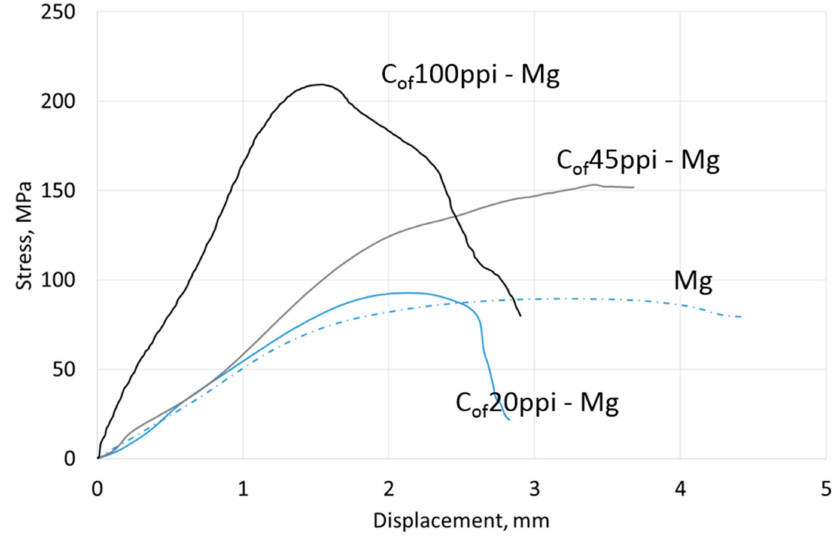
Figure 6. Representative curves obtained in compressive strength tests of Mg matrix composites with C of 20ppi, C of 45ppi and C of